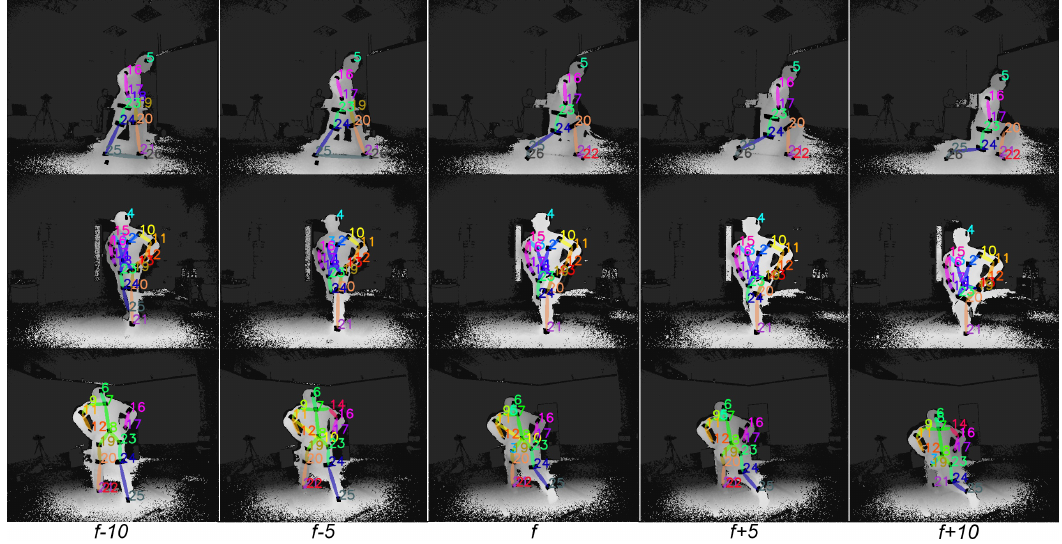
Figure 13. Visualization of the proposed FCN outcome overlayed on sequential multi-view depth frames. Five multi-view sequential frames, from frame f − 10 to f + 10 with frame step equal to 5, are horizontally